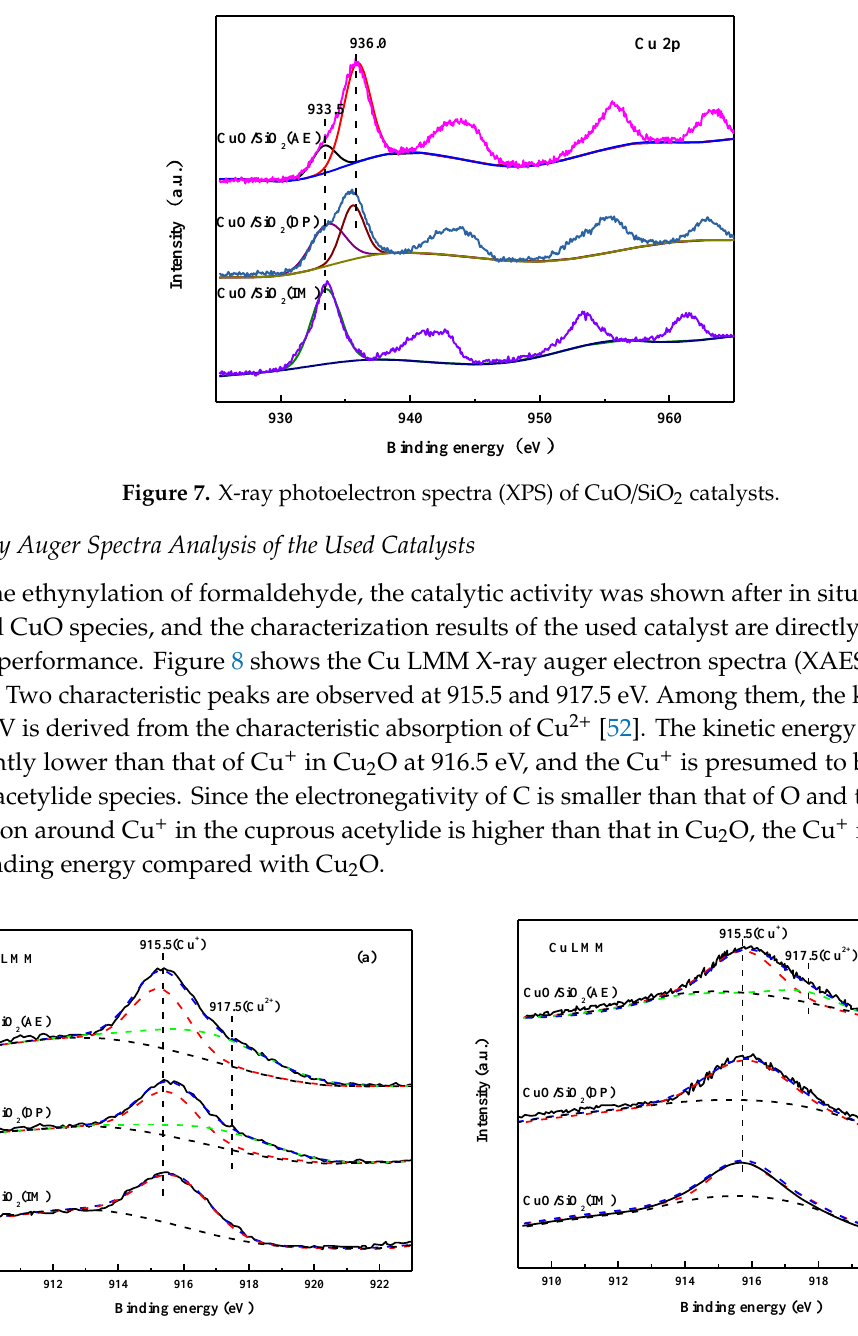
Figure 8. Cu LMM X-ray auger electron spectra (XAES) of CuO / SiO 2 catalysts used after ( a ) two cyclic reactions and ( b ) six cyclic reactions.